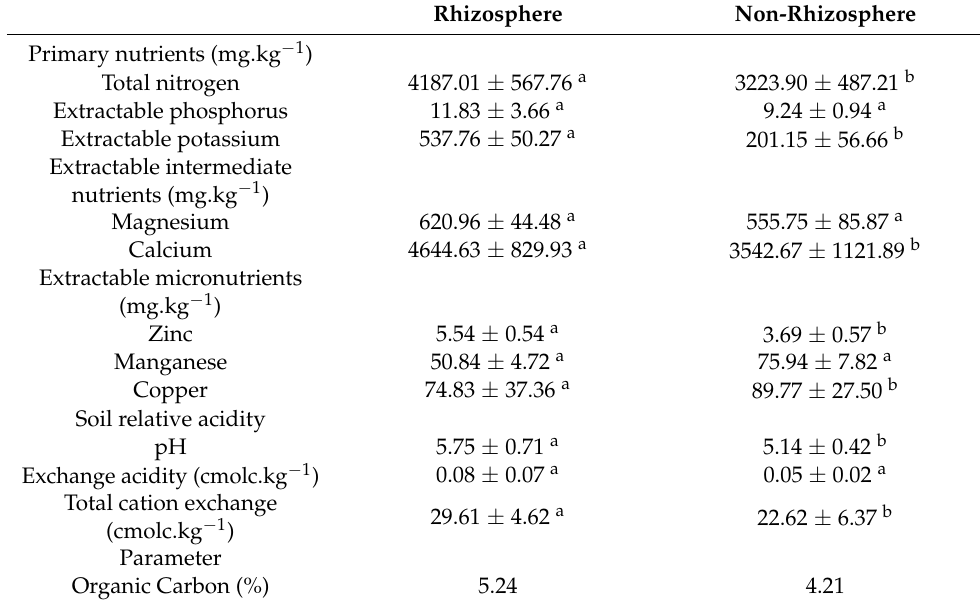
Table 1. Soil characteristics of Encephalartos natalensis rhizosphere and non-rhizosphere soils collected in a disturbed savanna woodland ecosystem at Edendale, Pietermaritzburg in the KwaZulu-Natal (KZN) province of South Africa. The results for primary nutrients, intermediate nutrients, micronu- trients, and soil relative acidity are represented as mean ± SE. Differing letters show significant differences (independent sample t -test, p ≤ 0.05, n =